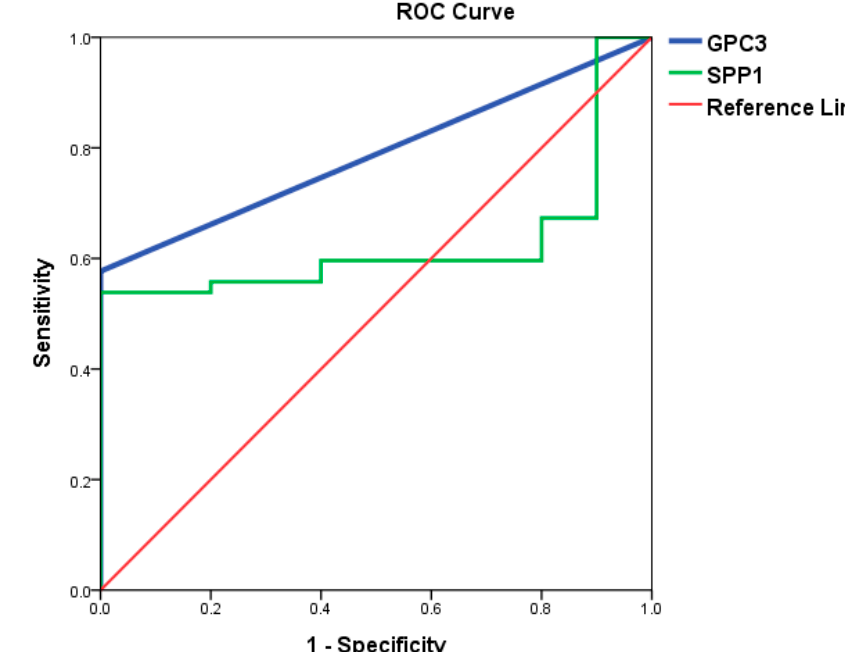
Figure 3. Performance of GPC3 and SPP1 ROC curves of GPC3 and SPP1 in di ff erentiating N-HCC from healthy subjects. The area under the ROC curve of GPC3 and SPP1 for N-HCC was 0.788 ( P = 0.004) and 0.625 ( P = 0.213), respectively. GPC3, glypican 3; SPP1, secreted phosphoprotein 1; ROC, receiver